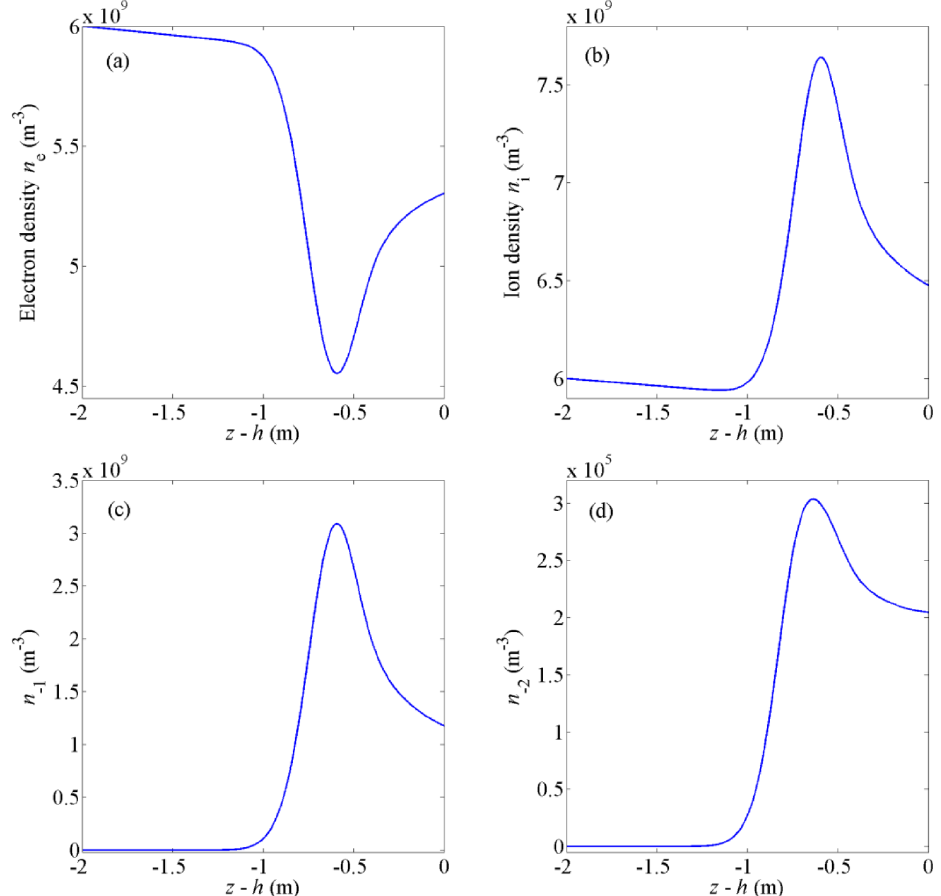
Figure 6. The number density distribution of (a) electrons, (b) ions, (c) particles carrying one negative charge, and (d) particles carrying two negative charges near the upper boundary of the condensation layer at t =